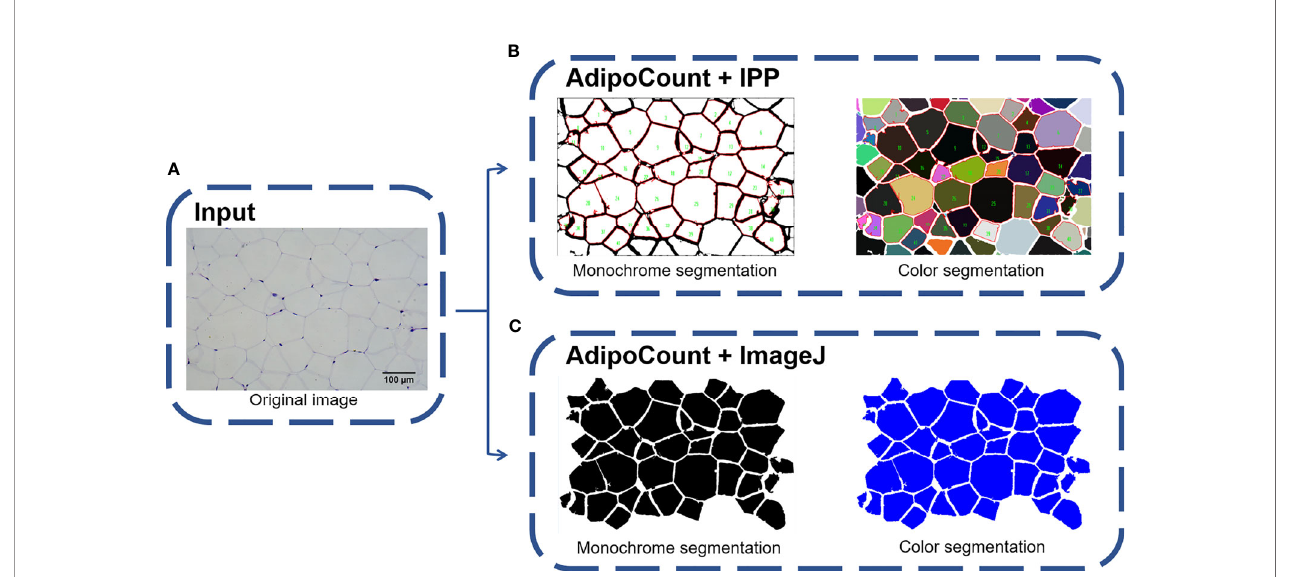
FIGURE 3 | Combination of AdipoCount and IPP/Image identi fi es adipose cells accurately. (A) Original image of adipocytes. (B) Combination of AdipoCount and IPP, the identi fi cation results of monochrome segmentation image (left), and color segmentation image (right). (C) Combination of AdipoCount and ImageJ, the identi fi cation results of monochrome segmentation image (left), and color segmentation image (right). IPP, Image-Pro